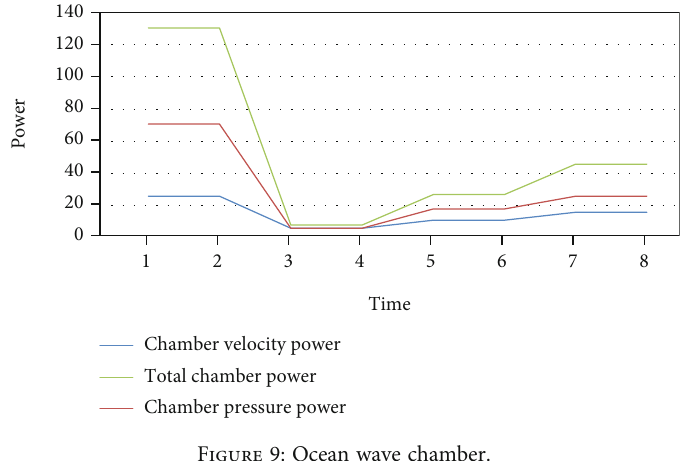
Figure 9: Ocean wave chamber.